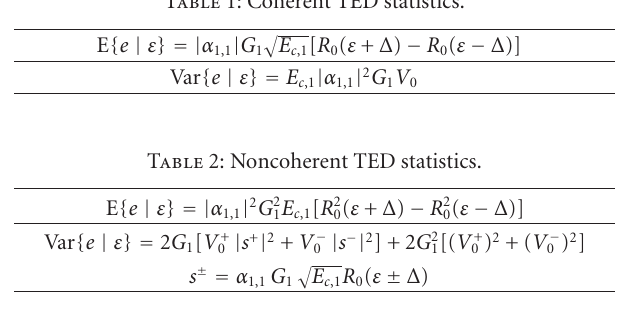
Table 1: Coherent TED statistics.